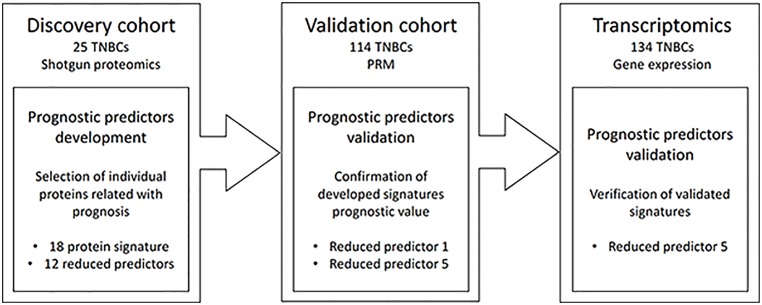
Study design.Chart of samples included and analysis performed in each cohort.